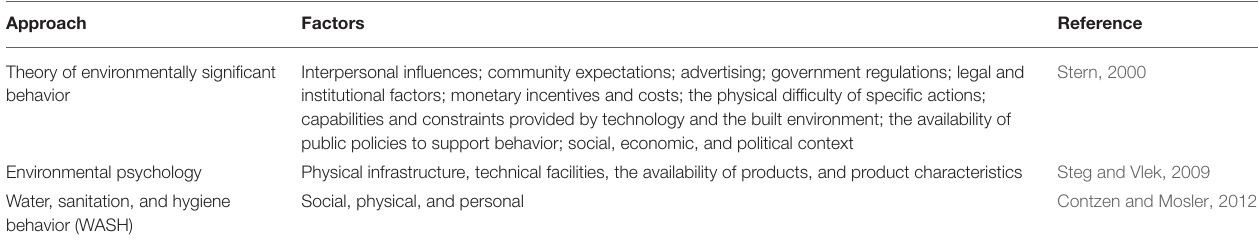
TABLE 4 | Examples of contextual factors that influence environmental